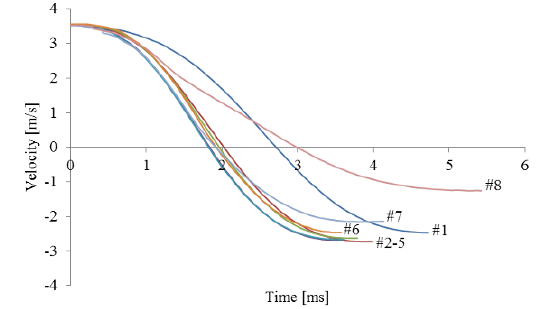
Figure 3. A time at maximum force longer than half of visible at impact #1 on the top surface of the